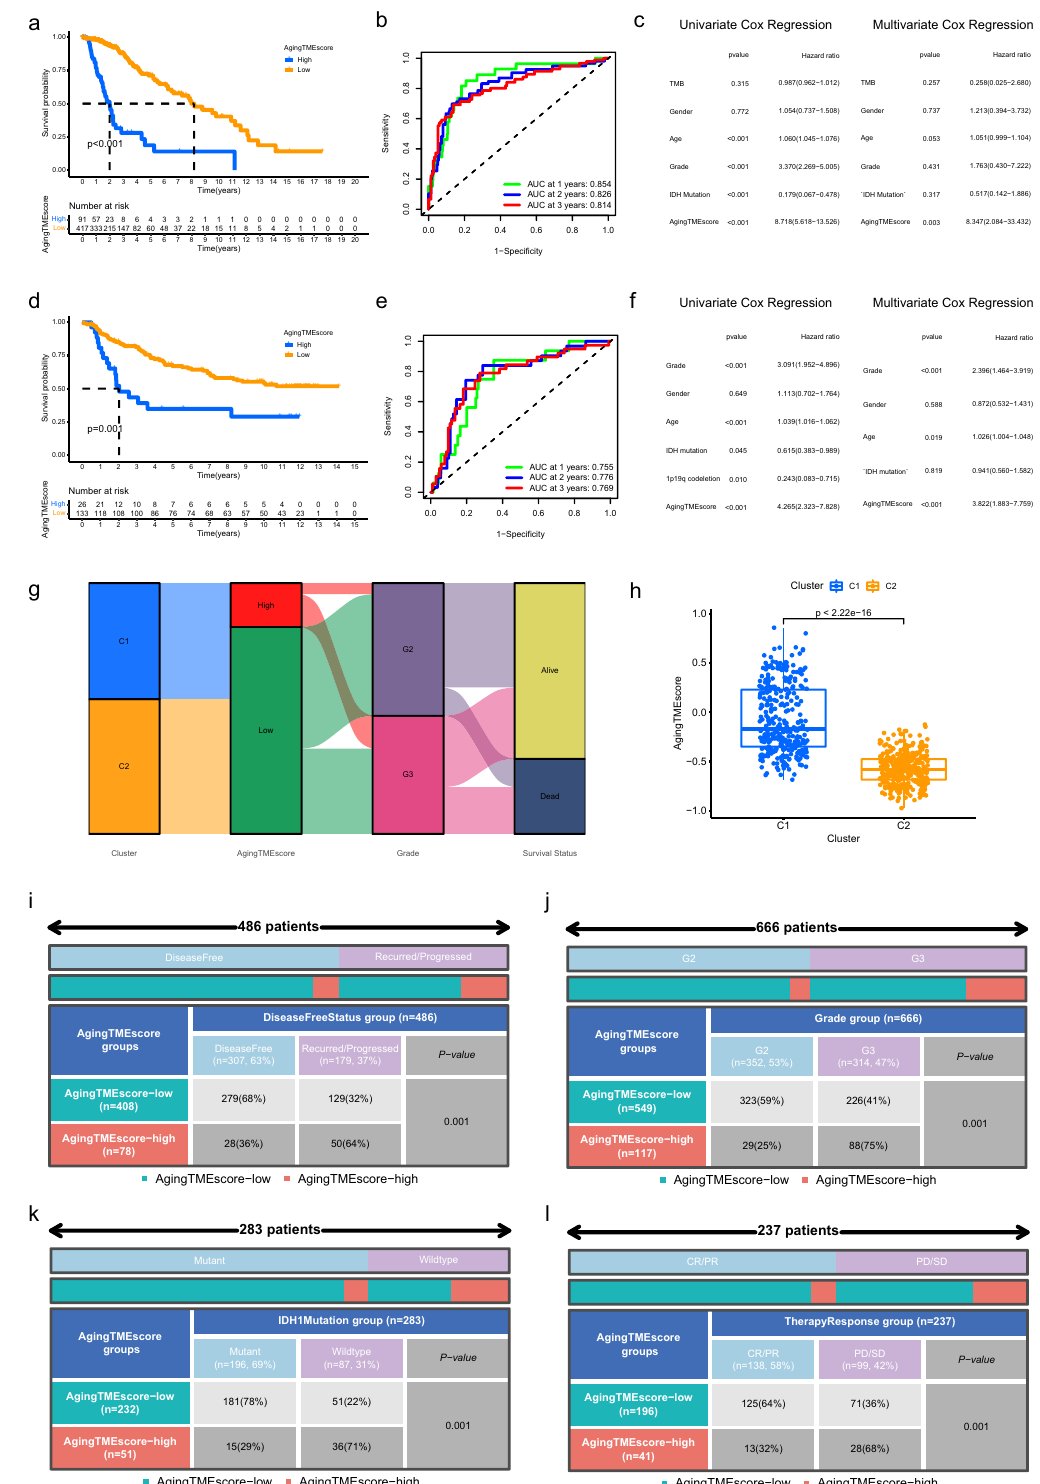
Figure 3. Comparison of the prognosis between low and high Aging TME score groups. ( a – f ) Kaplan–Meier survival analysis, time-dependent ROC curves and univariate/multivariate cox regression analysis of aging TME score in TCGA cohort ( a – c ) and CGGA cohort ( d – f ), respectively. ( g ) Alluvial diagram of clusters, aging TME score groups, grade and survival status. ( h ) Comparisons of aging TME scores between C1 and C2. ( i – l ) Correlation between aging TME score and disease free status ( i ), grade ( j ), IDH1 mutation status ( k ), conventional therapy response ( l ). LGG, low-grade glioma; ROC, receiver operating characteristic; AUC, area under curves; TME, tumor